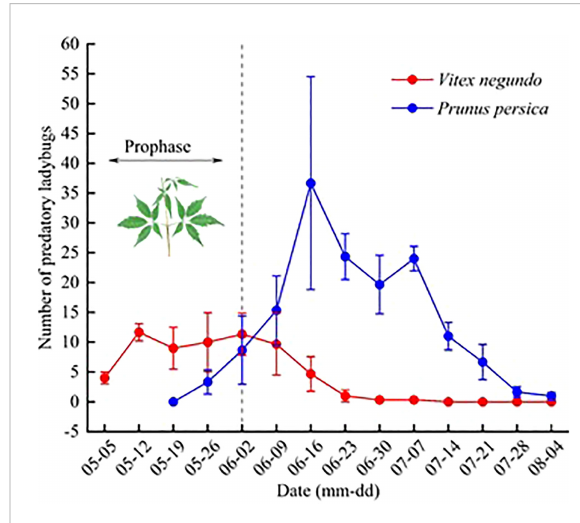
FIGURE 2 Occurrence dynamics of predatory ladybugs on Vitex negundo and adjacent peach trees. Note: Mean (± SE) per plot.